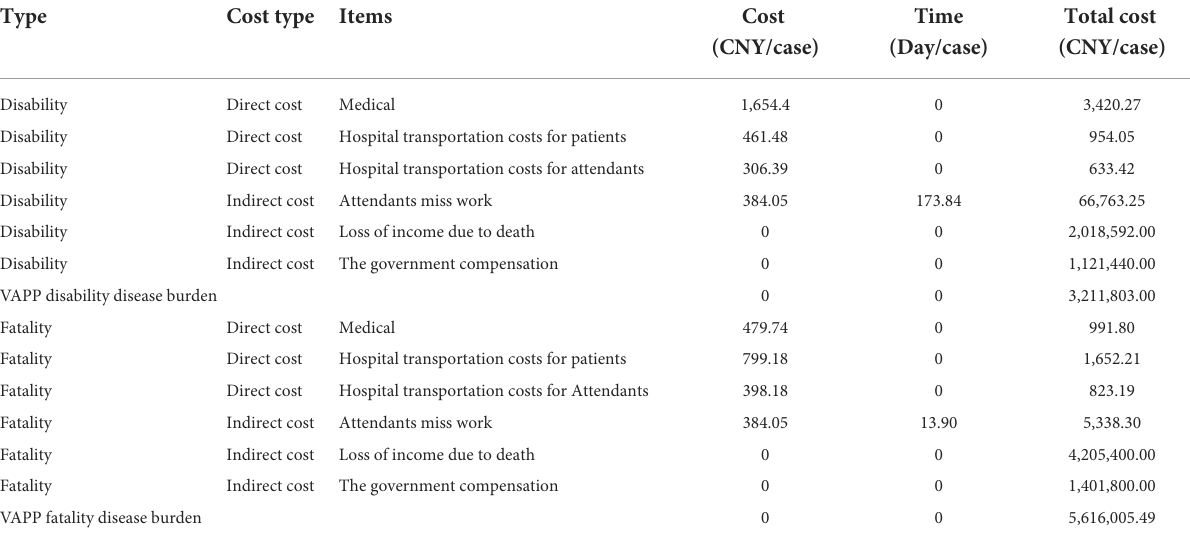
TABLE 2 Disease burden of VAPP disability and fatality